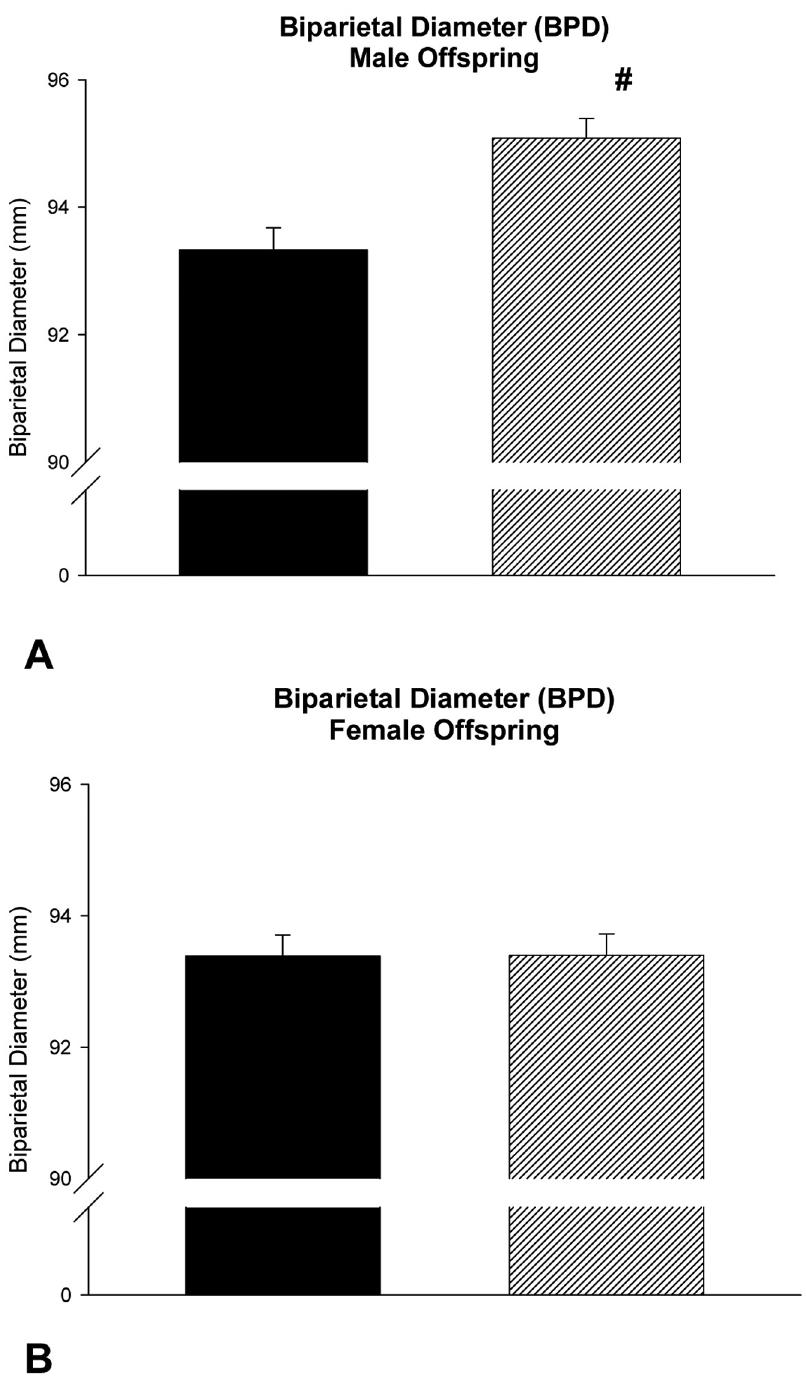
Figure 1. Biparietal diameter of male (A) and female (B) offspring in relationship to paternal BMI. Ultrasound examination was done in average at gestational day 266.8. Black Bar: Paternal BMI below median; Hatched Bar: Paternal BMI above median. # : p=0.008 versus male offspring of fathers with a BMI below the median of all paternal BMI data of the cohort; Data are given as mean + / 2 SEM.